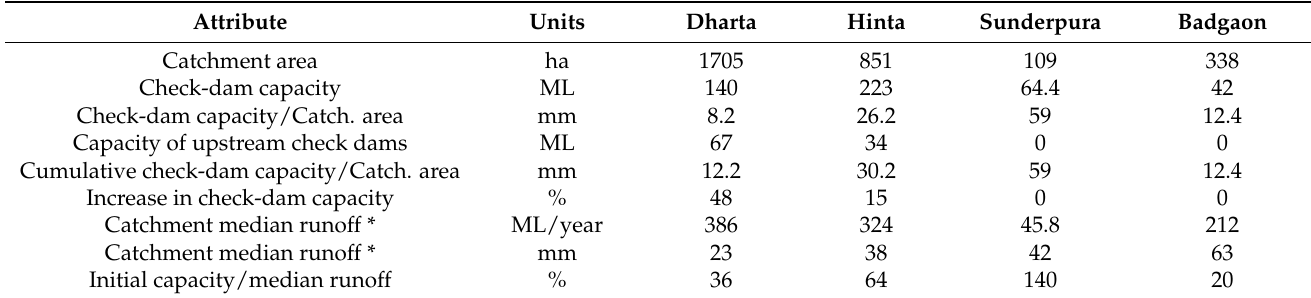
Table 4. Capacities of existing check dams in all catchments.